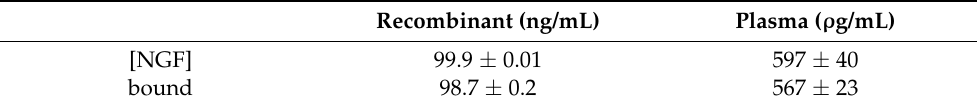
Table 4. Quantification of NGF recombinant or derived from a pool of rat blood plasma, and the binding capacity of the eFM-NGF